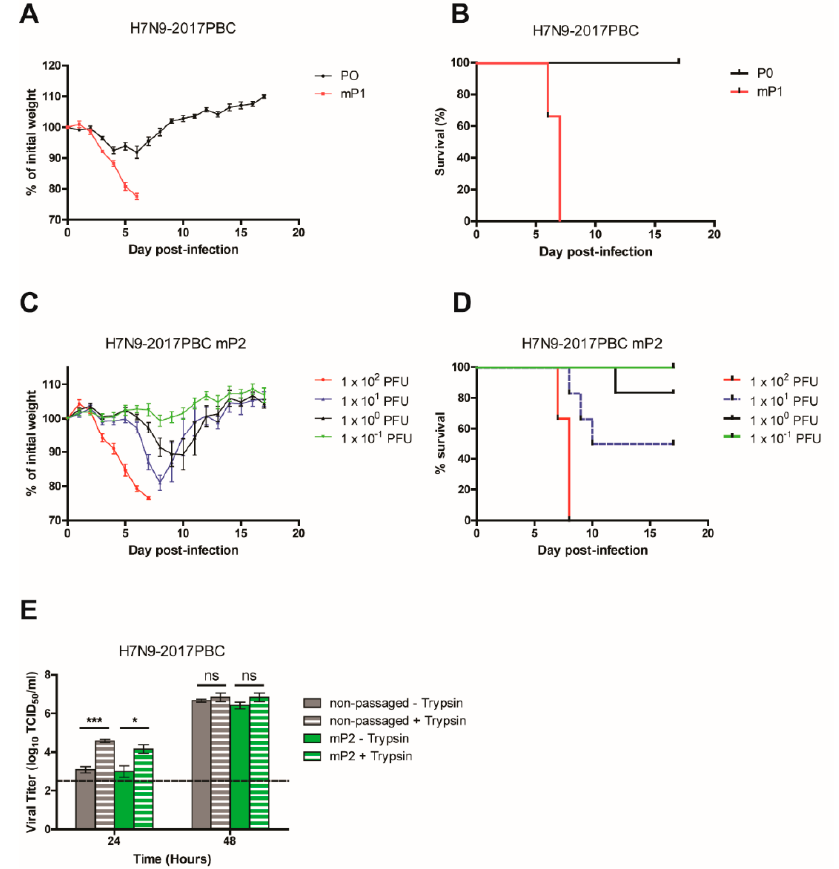
Figure 6. Characterization of H7N9-2017PBC virus in mice. ( A ) Weight loss and ( B ) survival of mice infected with either 3.2 × 10 5 PFU of H7N9-2017PBC virus (P0, n = 6) or 50 µ L of lung homogenate collected from one H7N9-2017PBC infected-mouse that was sacrificed on day 4 post-infection (mP1, n = 4). ( C ) Weight loss and ( D ) survival of mice ( n = 6) infected with a dose range of 10 − 1 to 10 2 PFU of lung homogenate from the second mouse passage (mP2) of H7N9-2017PBC virus. ( E ) In vitro growth of H7N9-2017PBC influenza virus in the presence or absence of trypsin. MDCK cells were infected with either non-passaged or mouse-passaged (mP2) versions of H7N9-2017PBC viruses at a MOI of 0.001, with 1 µ g / mL of trypsin supplemented to the growth medium ( + trypsin) or without (– trypsin). Viral titers were determined at 24 h and 48 h post-infection by TCID 50 assay. Dotted line on each graph represents the limit of detection of the TCID 50 assay. Mean viral titers and standard error of mean (SEM) are shown, two-way ANOVA with Bonferroni post-tests was performed, ns = not significant, * p -value < 0.05, and *** p -value < 0.001.